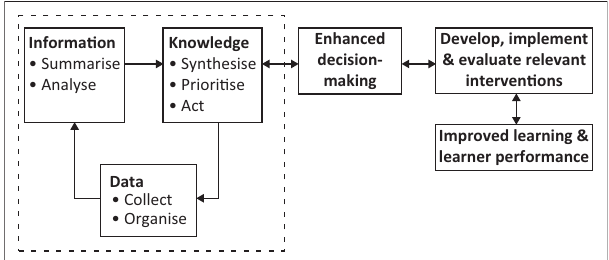
FIGURE 1: Conceptual model for using assessment